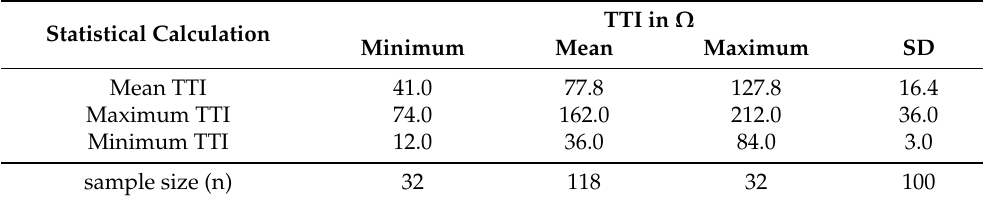
Table 2. Statistical analysis of mean TTI, maximum and minimum TTI of all collected